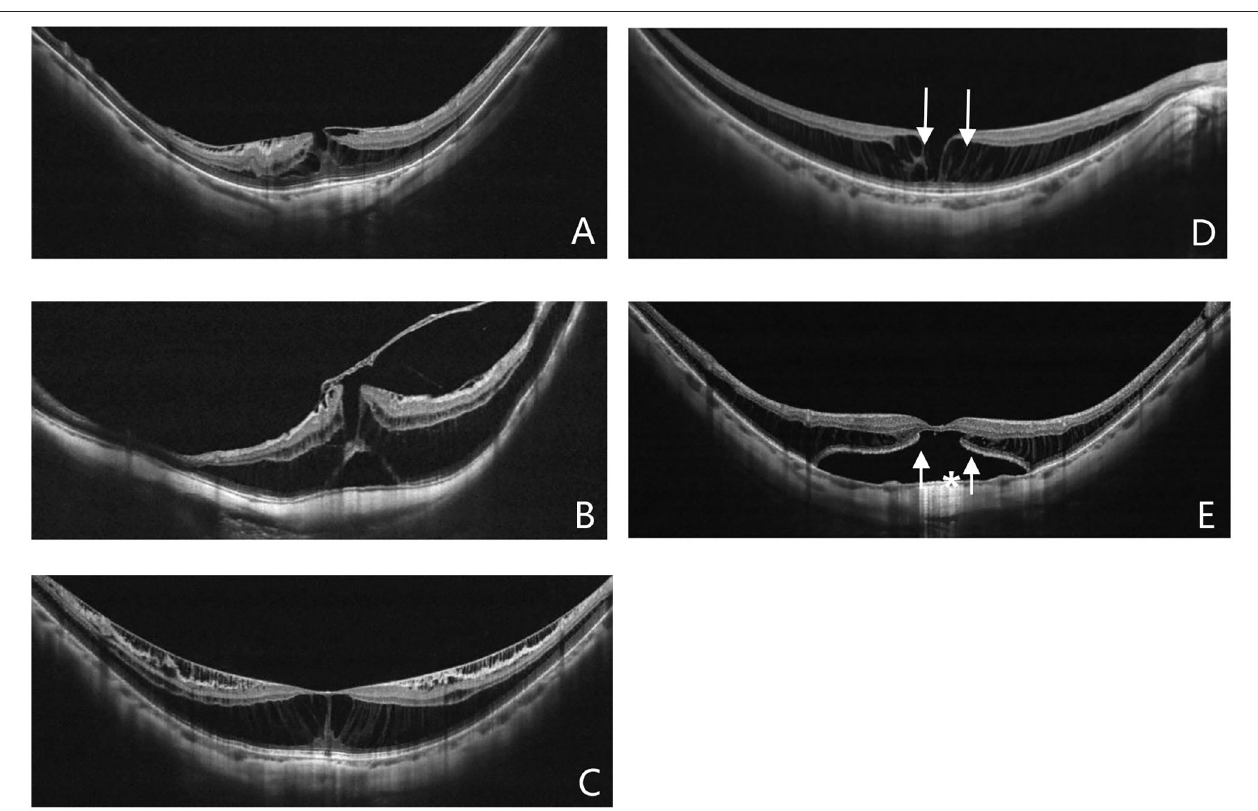
FIGURE 1 | Different pattern of VMIAs (A,B) : Epiretinal membrane (A) , Vitreomacular traction (B) . The anatomical configurations of myopic foveoschisis (MF) in optical coherence tomography (OCT) (C–E) : MF alone (C) , inner lamellar macular hole ( D , white arrow), outer lamellar macular hole ( E , white arrow), foveal detachment ( E , white